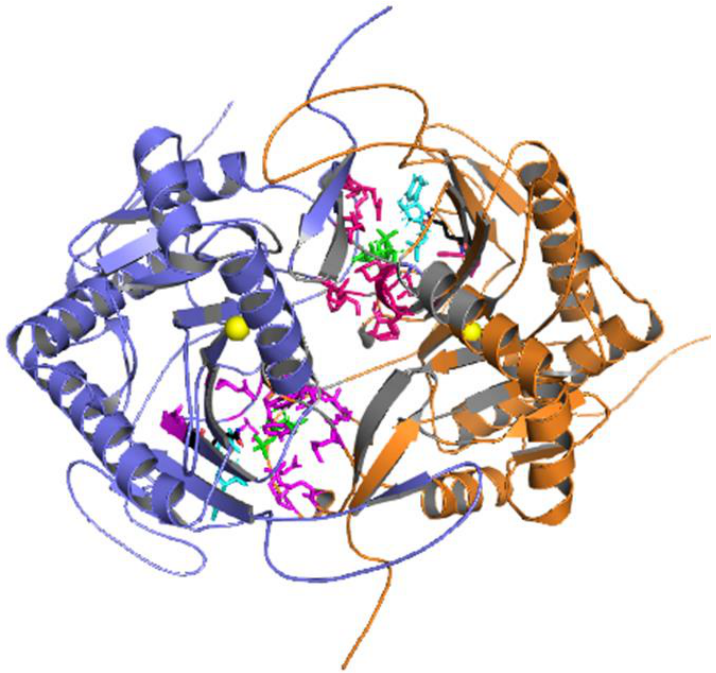
Figure 1. Structure of the model of the homodimeric GALT enzyme. Chain A is in blue, chain B in orange. The residues of the two active sites are represented in stick and colored in magenta, with the residue in position 188 in black. Galactose-1-phosphate (G1P) is in green and 5,6-dihydrouridine-5′-monophosphate (H2U) is in cyan. Zn ions are represented as yellow spheres.